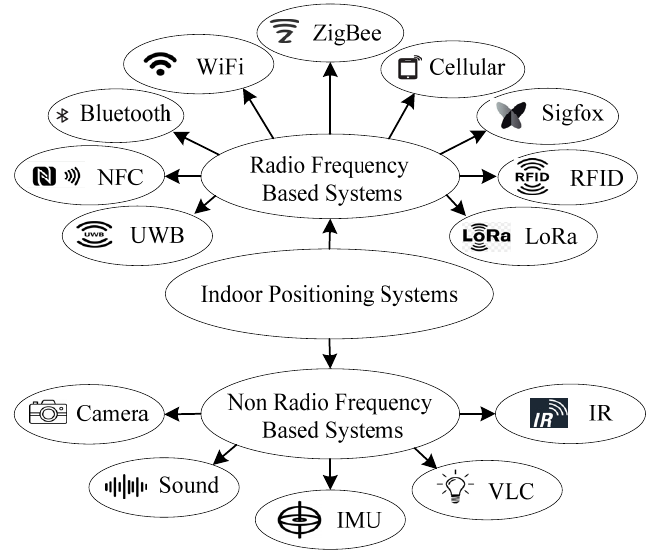
Figure 7. Categorization of indoor positioning technologies.